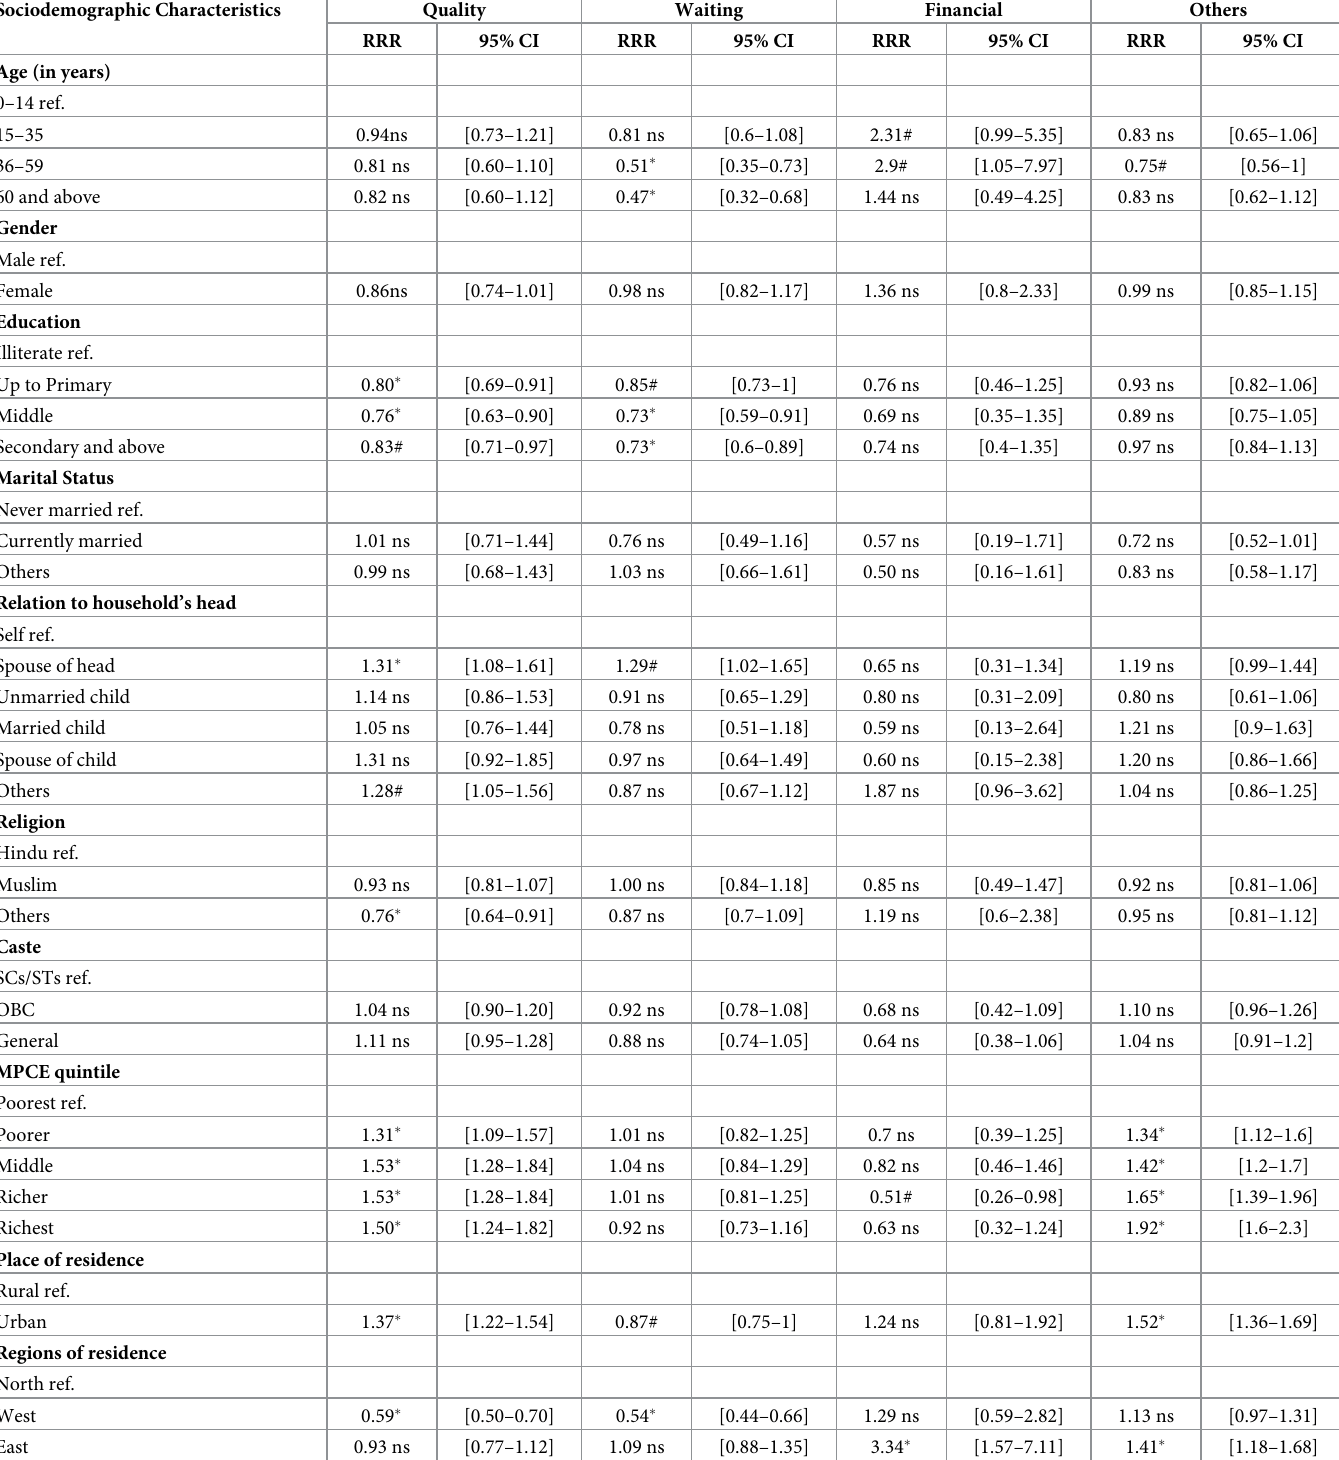
Table 8. Results from the multinomial regression models to examine the effect of sociodemographic characteristics on Unmet need for treatment-seeking for public health facilities, India, NSS, 2018. Sociodemographic